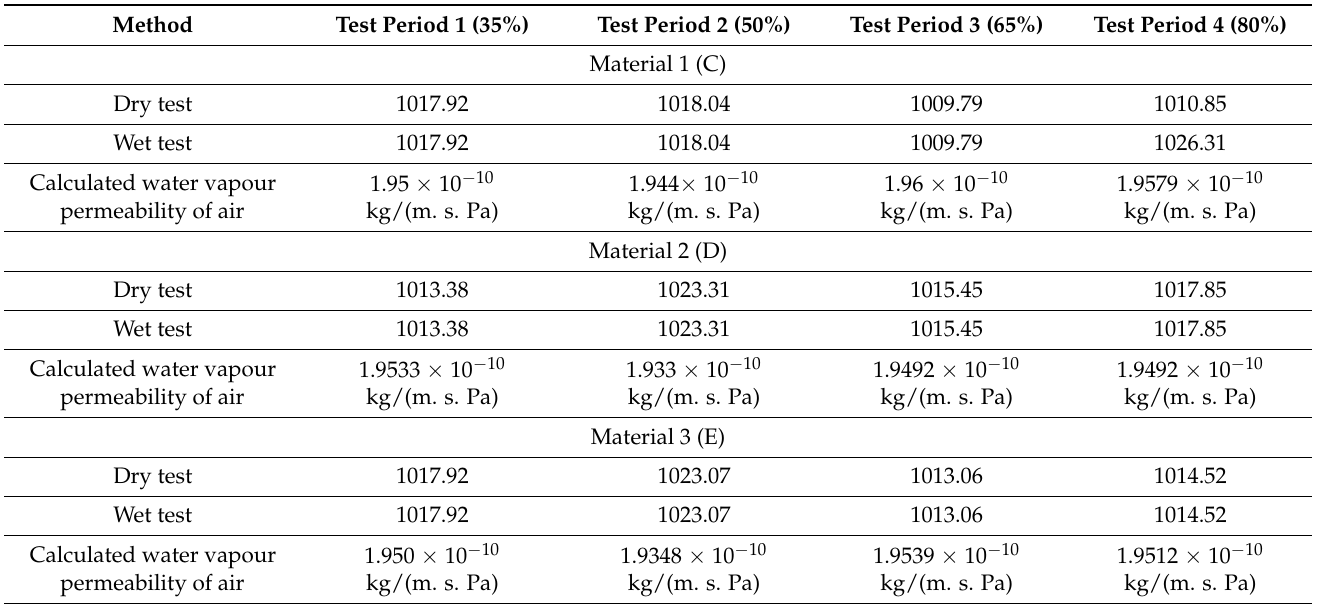
Table 2. Average barometric pressure (Pa) and water vapour permeability of air for each